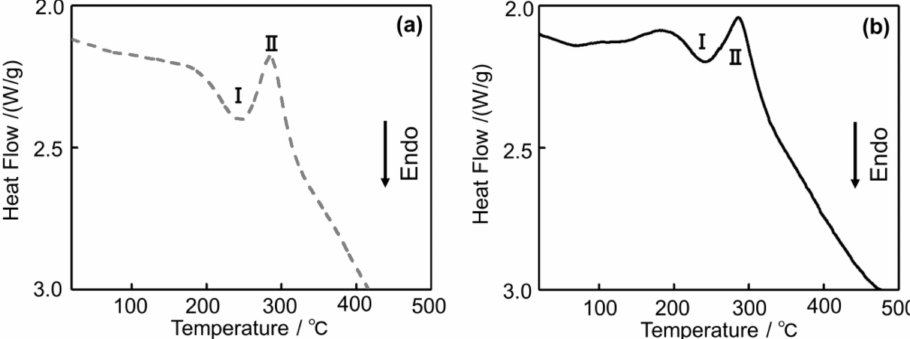
Figure 13. Differential Scanning Calorimeter (DSC) curves of the A2024 alloy foams: ( a ) Melt-A2024; ( b ) Semi-A2024.